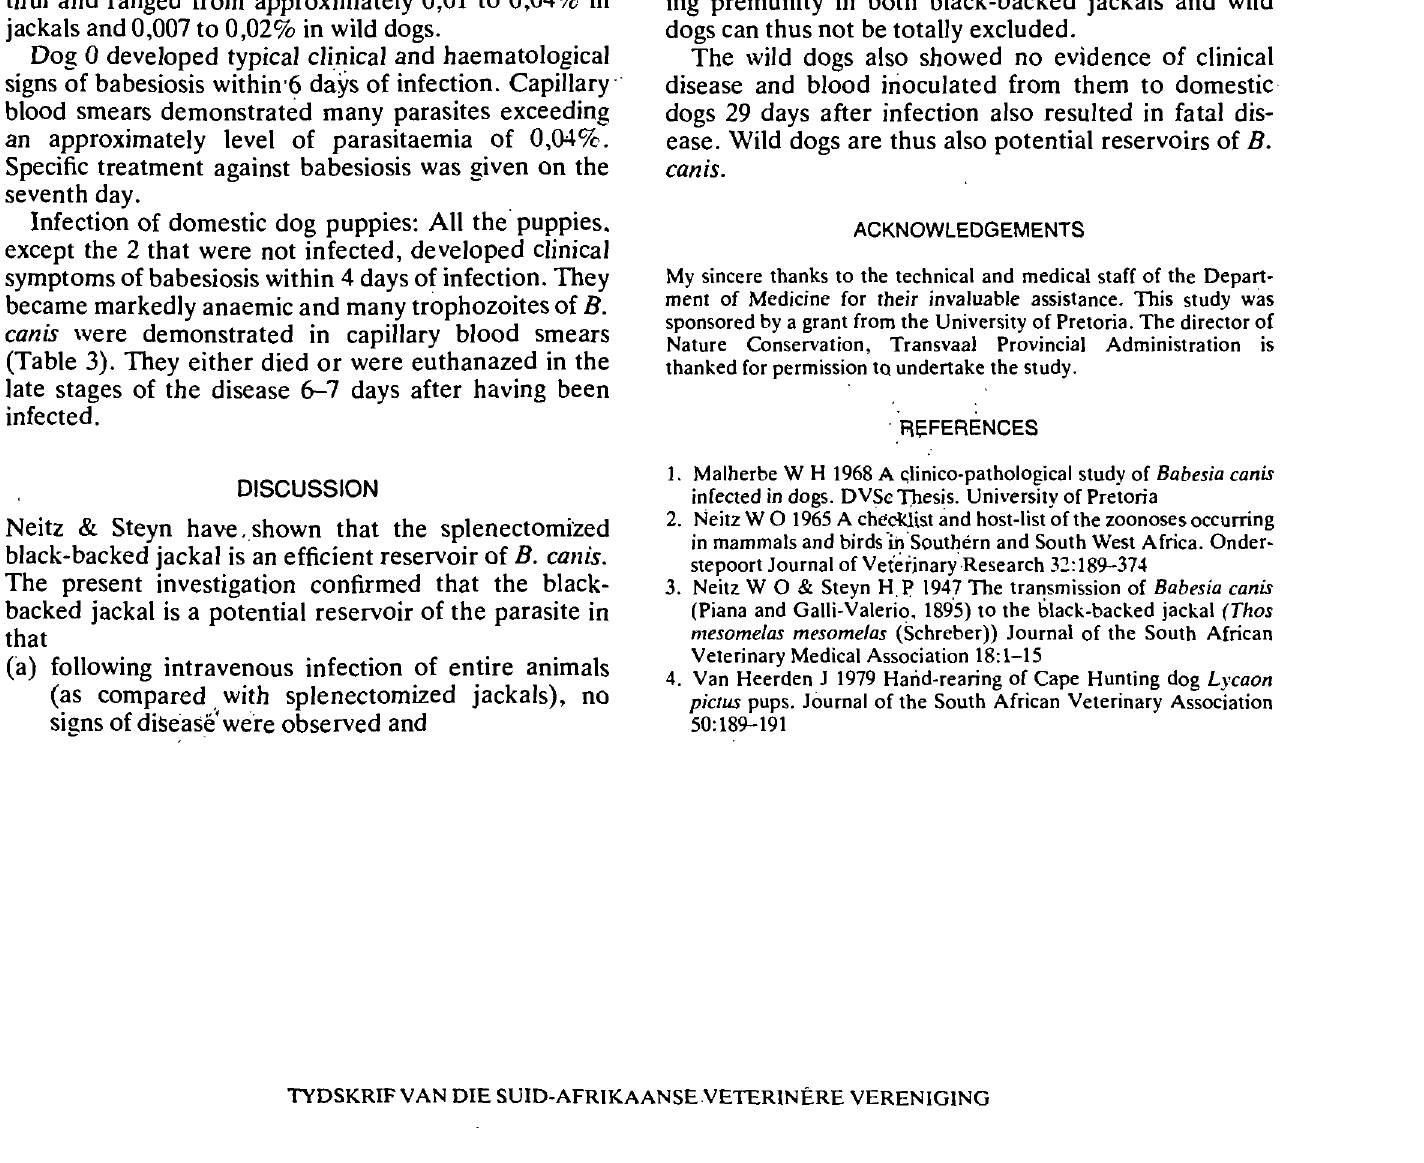
·Died suddenly on third